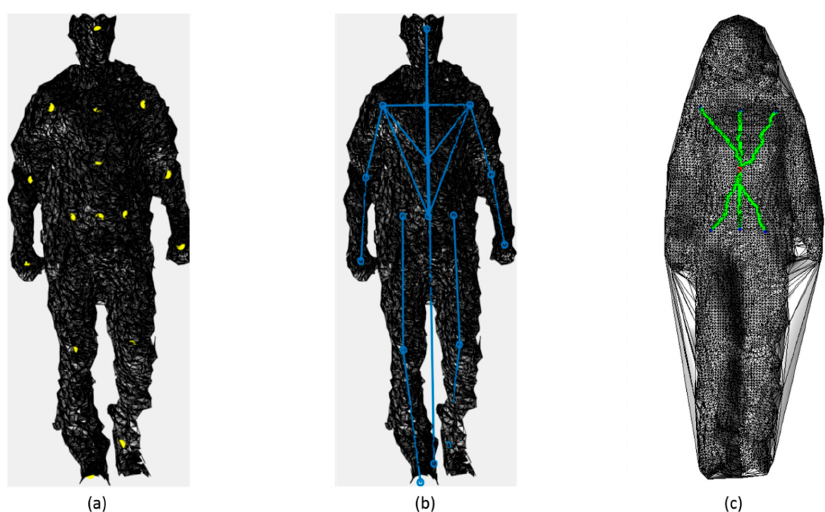
Figure 5. Selected skeleton joints, geodesic and Euclidean distance among them; ( a ) Projection of skeleton joints on the three-dimensional body point cloud, ( b ) Euclidian distance of selected skeleton segments, and ( c ) Sample of geodesic paths used in constructing surface-based feature vector. The surface-based feature vector is the last vector in the configural features group. This feature vector is computed using the combination of geodesic distances among the projection of selected skeleton joints on the three-dimensional body point cloud. First, the selected pairs of the skeleton joints, which do not usually lie on the point cloud, are projected on the associated closest point on the three-dimensional body mesh, which is generated from the point cloud. The pair of the projection points is used to initiate the fast-marching algorithm that provides a good approximation of the shortest geodesic path between two points on the surface. The fast-marching algorithm uses a gradient descent of the distance function to extract a good approximation of the shortest path (geodesic), as given by the Dijkstra algorithm [40]. Figure 5c depicts an example of geodesic distances used in constructing the surface-based feature vector. The selected geodesic distances that used to construct the surface-based feature vector are described in Table A3 (Appendix B).